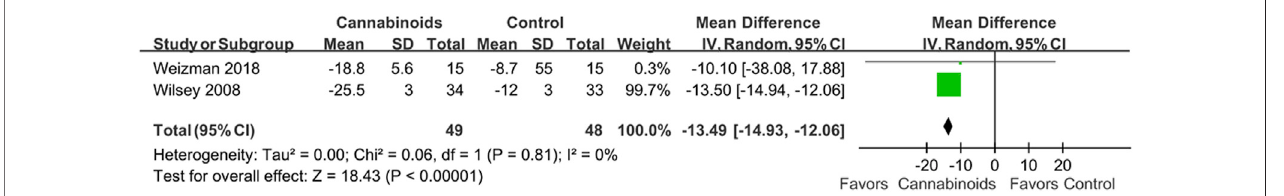
FIGURE 6 | Post hoc analysis comparing cannabinoids to placebo after including only studies reporting VAS as pain scores. Better pain control is shown by the favored side of the plot.